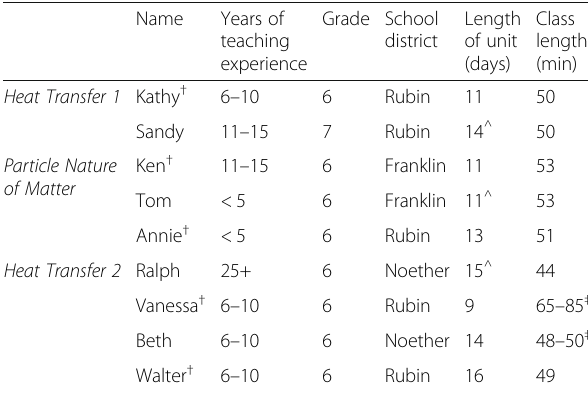
Table 1 Description of teacher participants and their